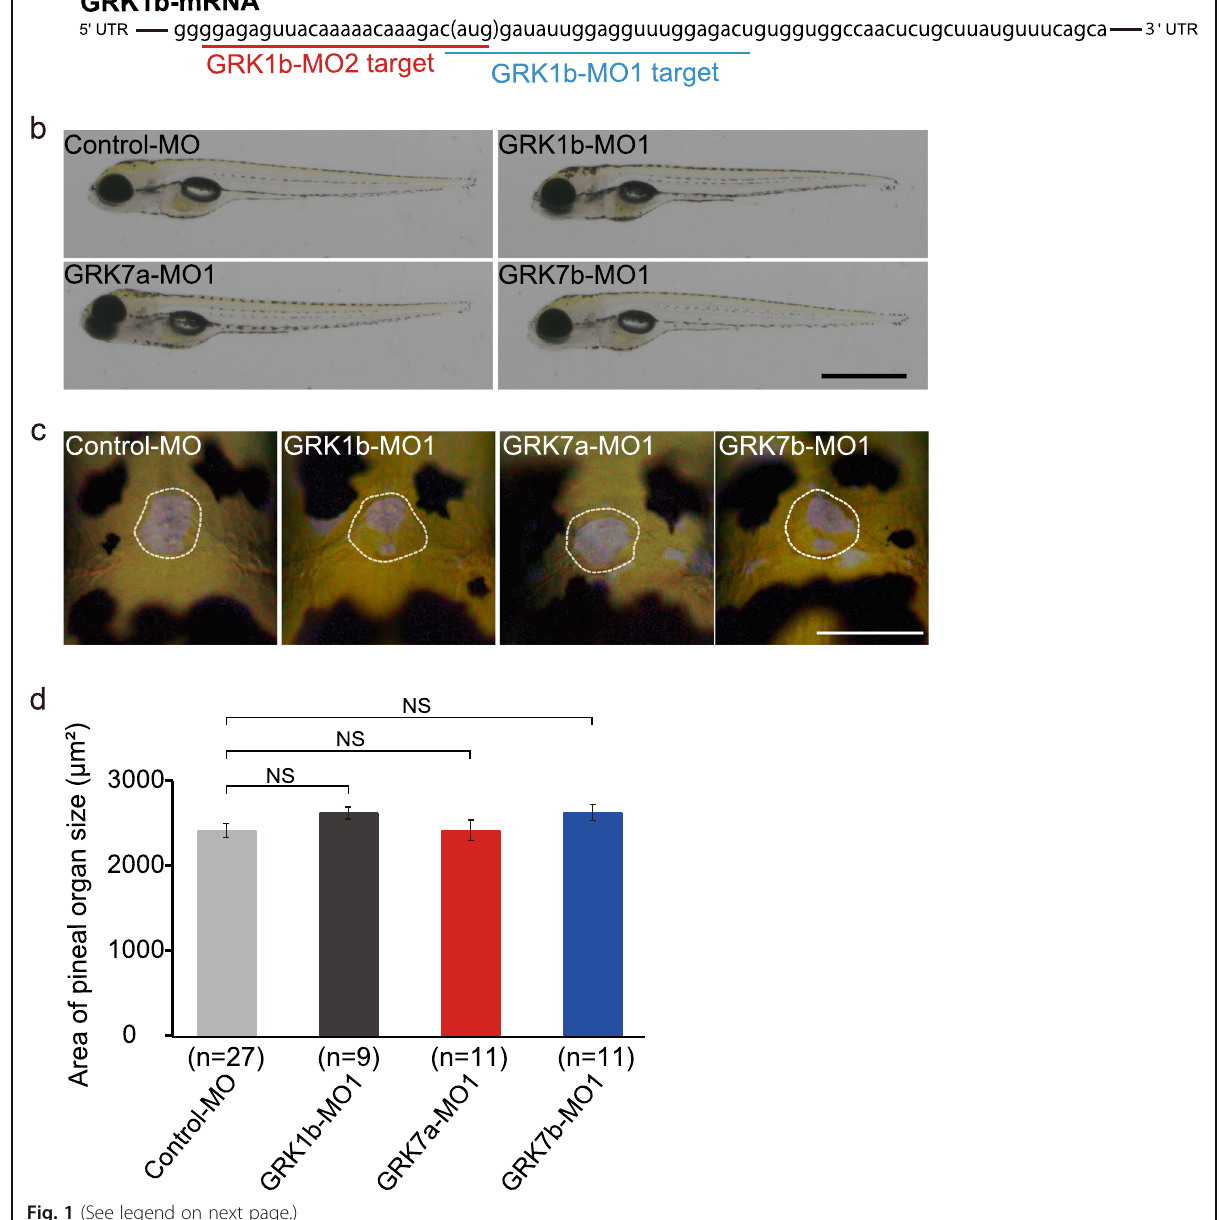
Fig. 1 (See legend on next